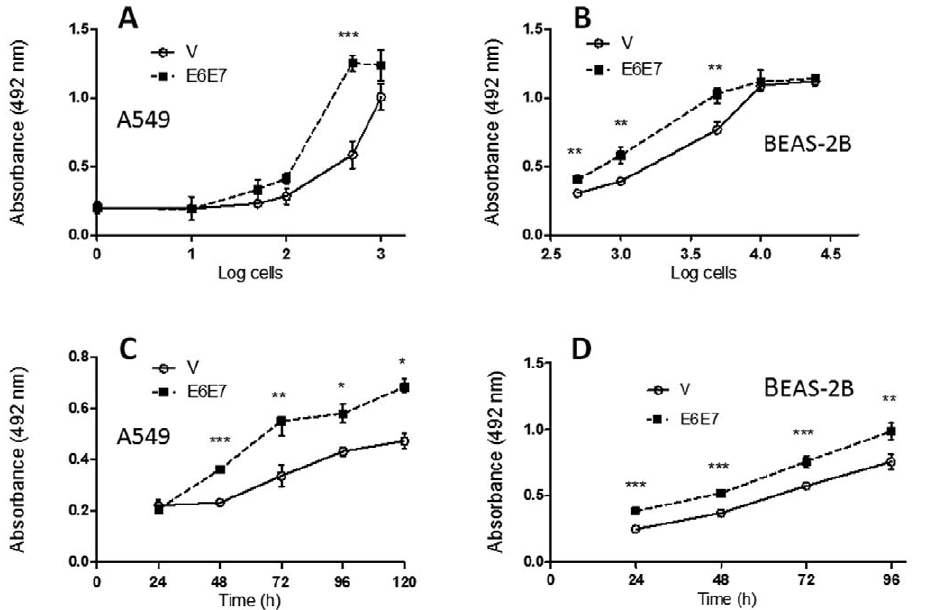
Figure 4. A549 and BEAS-2B lung cells transfected with pLXSNE6E7 constructs show an increased proliferation rate using MTS assays (mean 6 SE). A , B : Viability of A549 ( A ) and BEAS-2B ( B ) lung cells transfected with the empty vector and pLXSNE6E7 constructs. C , D : Proliferation curves of A549 ( C ) and BEAS-2B ( D ) cells transfected with PLXSNE6E7 and empty vectors (mean 6 SD, * p , 0.05; ** p , 0.01, *** p , 0.001, unpaired two-tailed Student’s t-test).